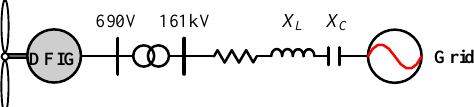
Figure 7. Diagram of a DFIG-based wind farm connecting the grid with a series-compensated transmission line.